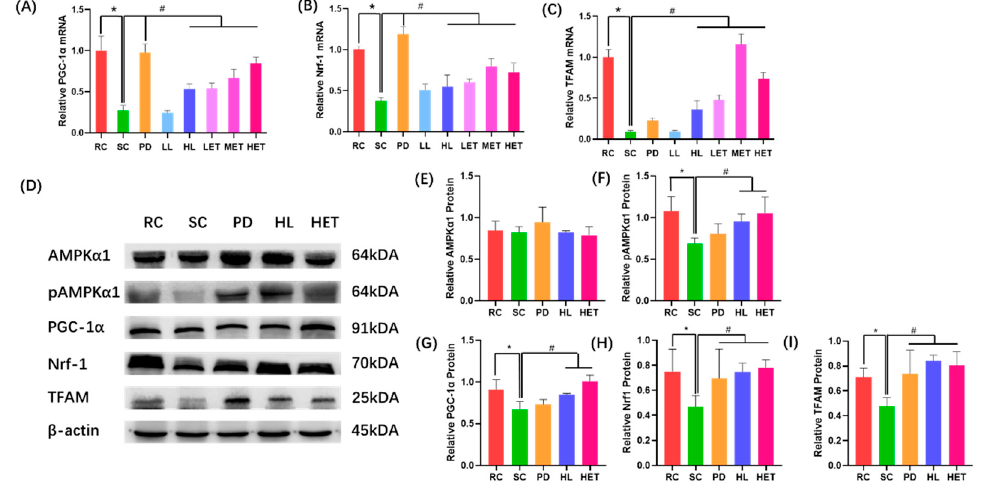
Figure 12. Molecular mechanism of LBP and LBPT regulating energy metabolism in muscle tissue of fatigue rats. ( A ) Relative expression of muscle PGC-1 α mRNA, ( B ) relative expression of muscle Nrf1 mRNA, ( C ) relative expression of muscle TFAM mRNA, ( D ) expression of AMPK/PGC-1 α pathway-related proteins, ( E ) relative expression of muscle AMPK α 1 protein, ( F ) relative expression of muscle pAMPK α 1 protein, ( G ) relative expression of muscle PGC-1 α protein, ( H ) relative expression of muscle Nrf1 protein, and ( I ) relative expression of muscle TFAM protein. Data are expressed as mean ± SD, N = 3. *: vs. RC p < 0.05, #: vs. SC, p < 0.05.